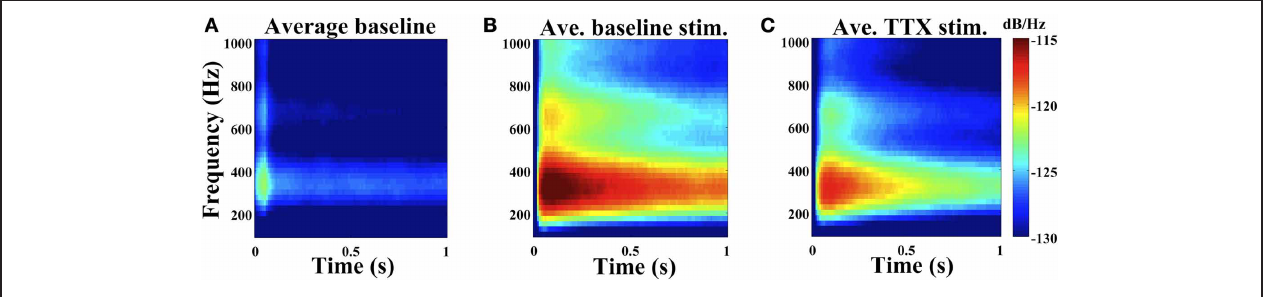
time 0 in the presence of 1 μ M TTX (C) . (A,B) : six cultures (two cortical and four hippocampal, 152 electrodes). (C) : three cultures (one cortical and two hippocampal, 106 electrodes); culture age 4–8 weeks.